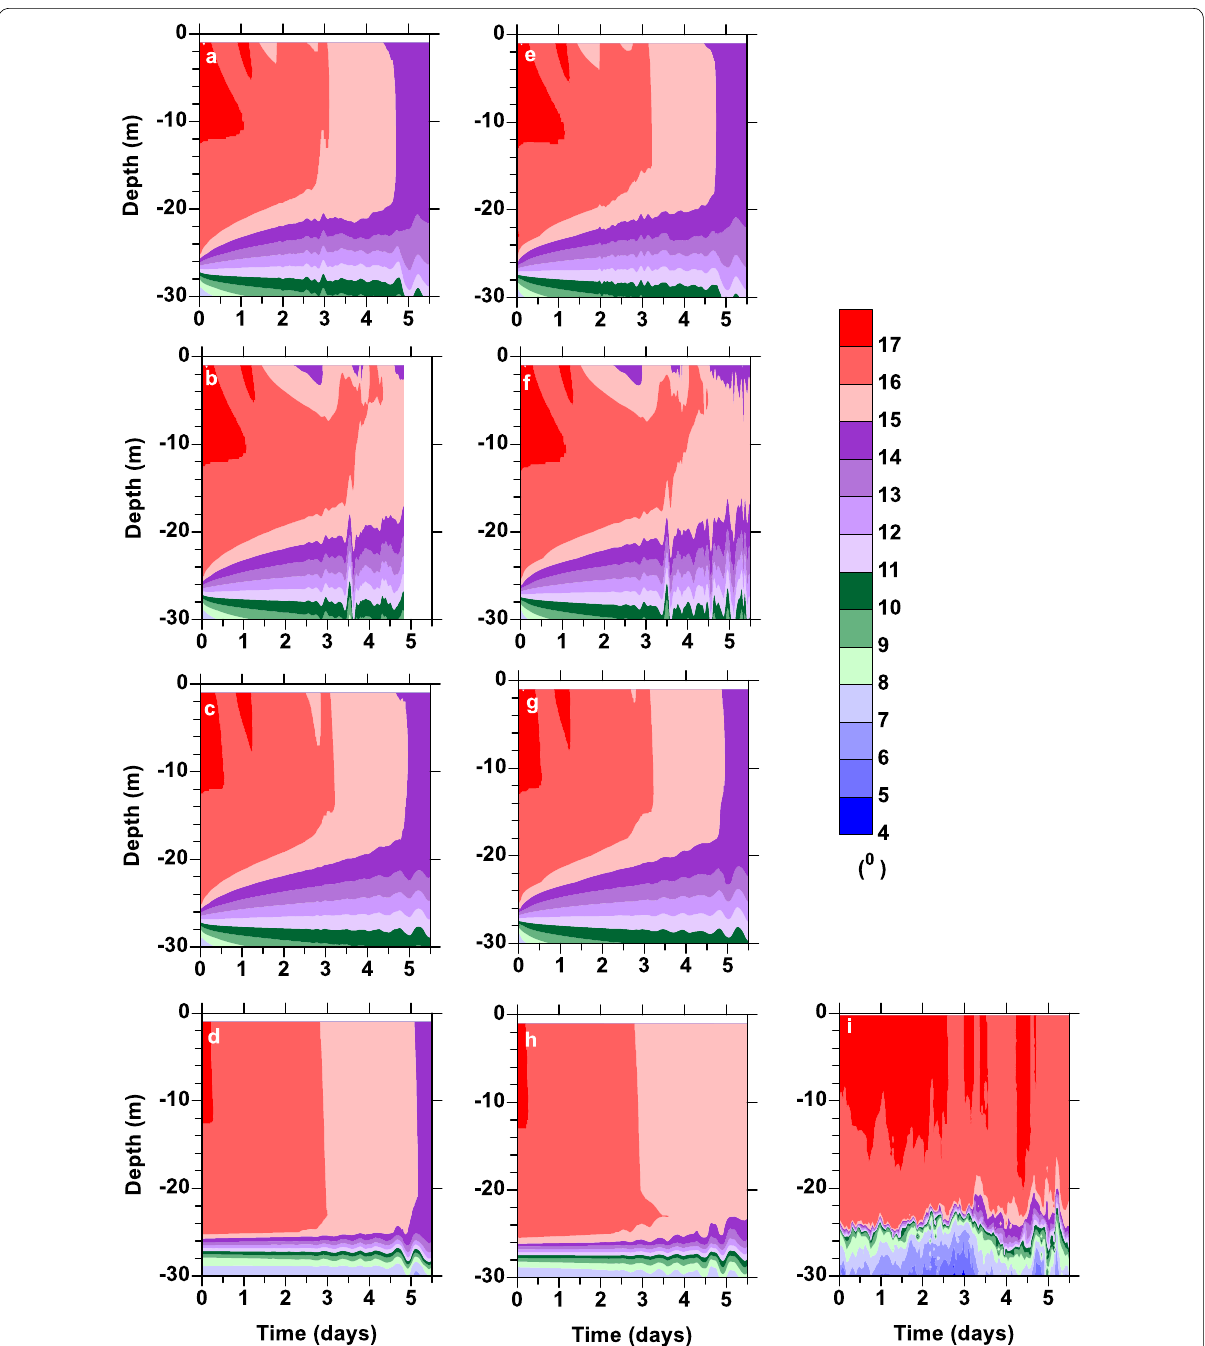
Fig. 6 Potential temperature with depth during the simulations for the first Baltic Sea cruise ( a – i ) the observations. The simulations were done with ( a – d ) 50 levels and ( e – h ) 25 levels. The results from Nakanishi – Niino are given in ( a , e ), those from Mellor – Yamada 2.5 in ( b , f ), those from GLS in ( c , g ), and Large – McWilliams – Doney in ( d , h